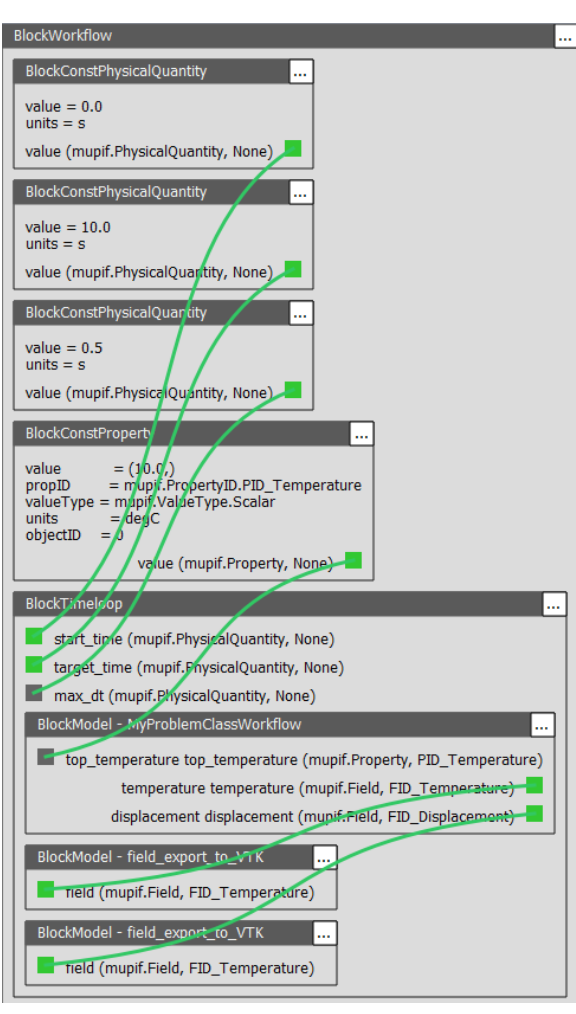
Figure 6. Execution workflow of the thermo- mechanical simulation with thermo-mechanical work- flow used as a